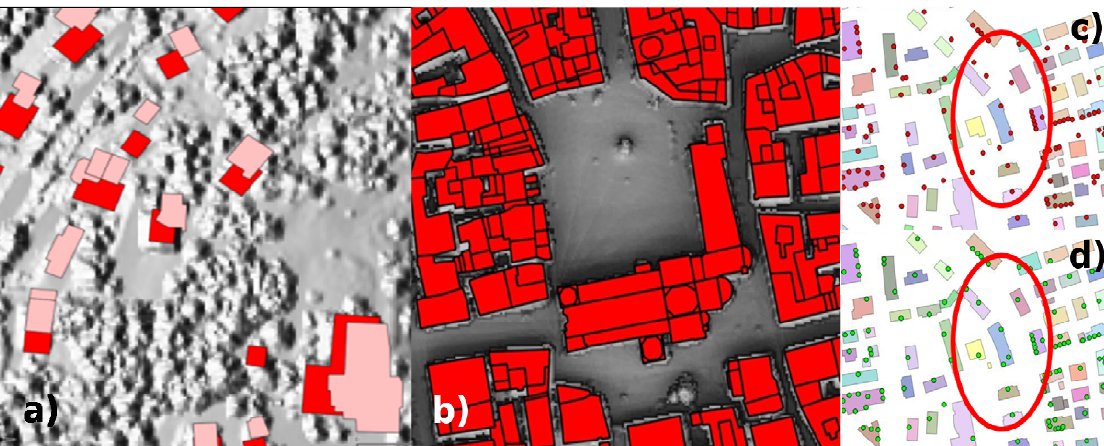
Figure 2 Examples of spatial datasets: a) Building footprints from land cadastre map (in pink) and from topographic map (in red). Planimetric misalignments between corresponding features, and with regards to the underlying DSM (in grey), are clearly visible; b) building footprints and sub-footprints around the main square of Trento. The church is a clear example of a complex structure represented by means of sub-footprints; c) example of home address points falling outside the corresponding building footprint; d) the home address points after semi-automatic